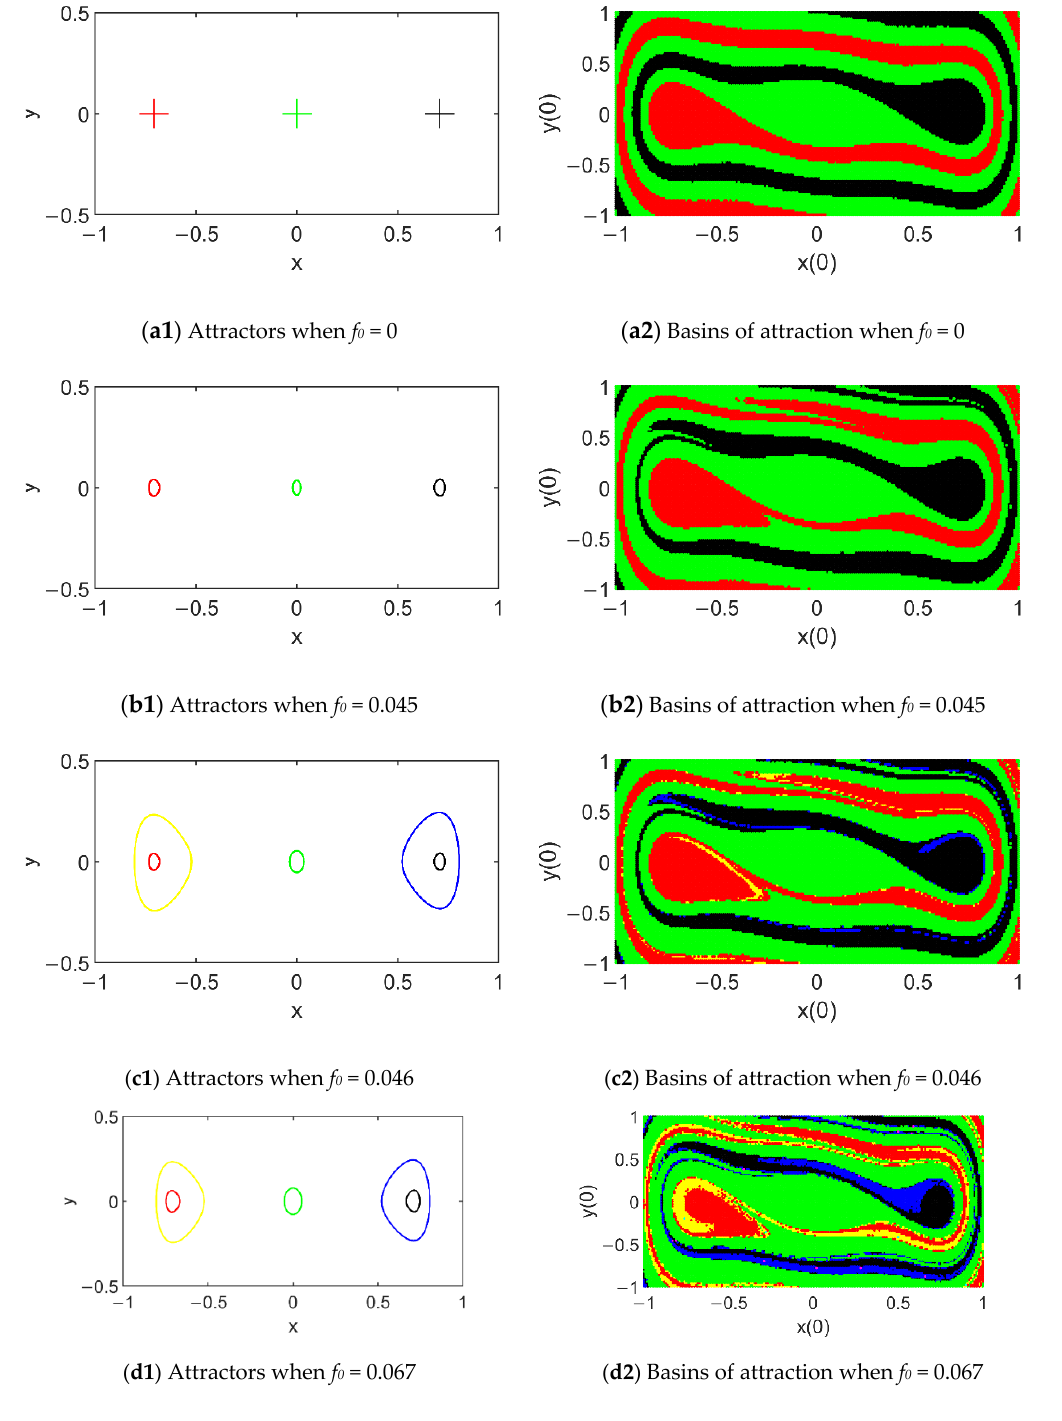
Figure 7. Evolution of attractors and their basins of attraction with the increase of f 0 for ω = 1.5.